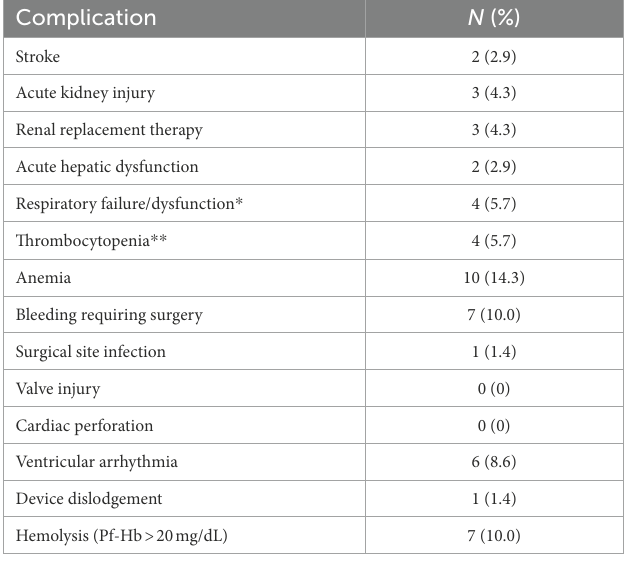
Pf-Hb: plasma free hemoglobin. * Respiratory failure/dysfunction is defined as the impairment of respiratory function requiring reintubation, tracheostomy or the inability to discontinue ventilatory support 48 h after Impella device explant. This excludes intubation for reoperation or temporary intubation for diagnostic or therapeutic procedures. ** Thrombocytopenia is defined as having a platelet count measurement of less than 50,000/mm 3 taken more than 48 h after the Impella